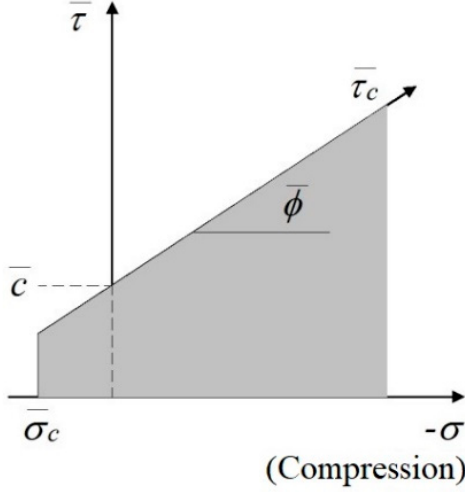
Figure 4. Failure envelope of the parallel bond.